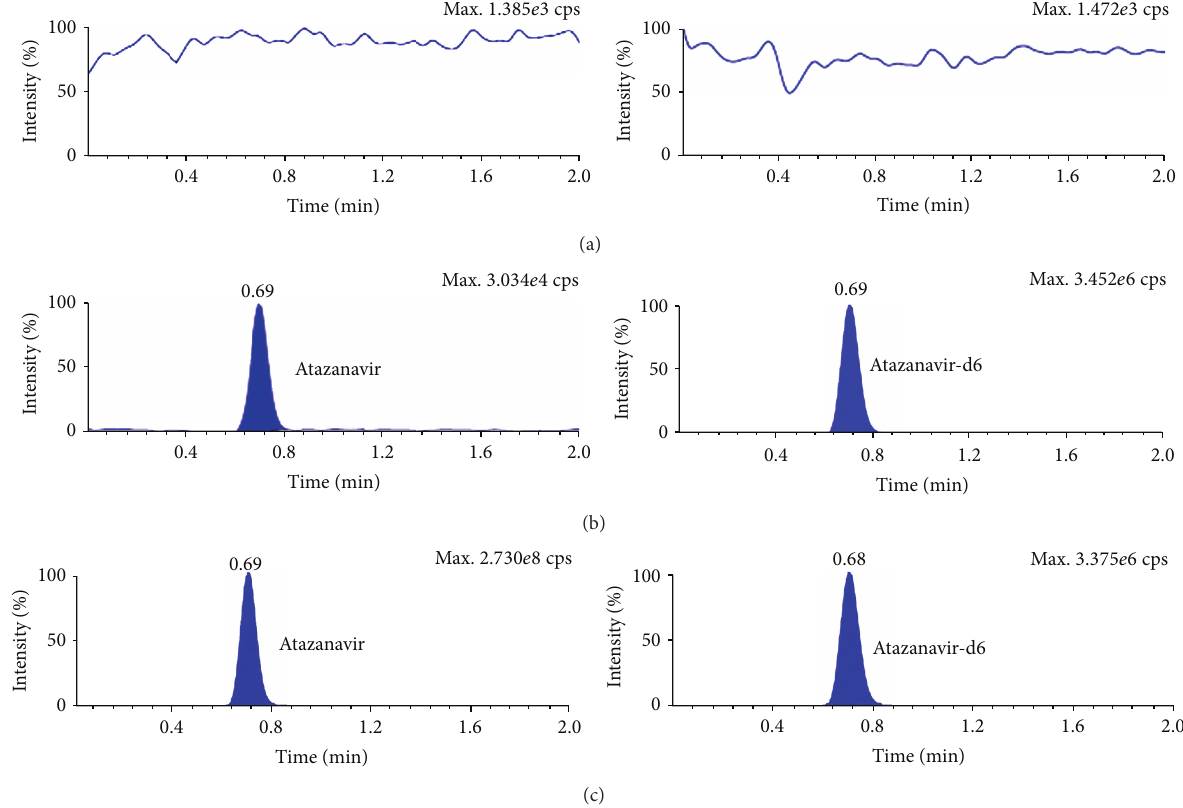
Figure 3: MRM ion chromatograms of atazanavir in (a) double blank plasma (without analyte and IS), (b) at LLOQ and atazanavir-d6, and (c) in real subject